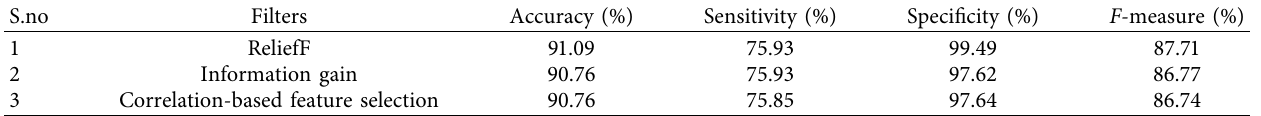
Table 3: Top 3 feature selection methods (filters) based on high performance.